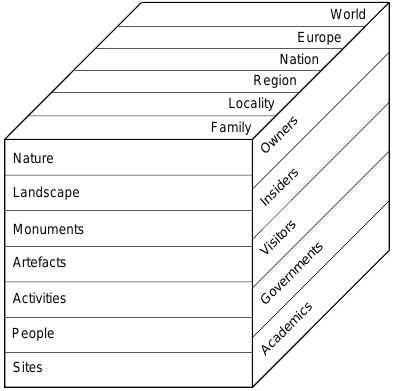
Figure 1. Heritage cube redrawn from Howard [12].